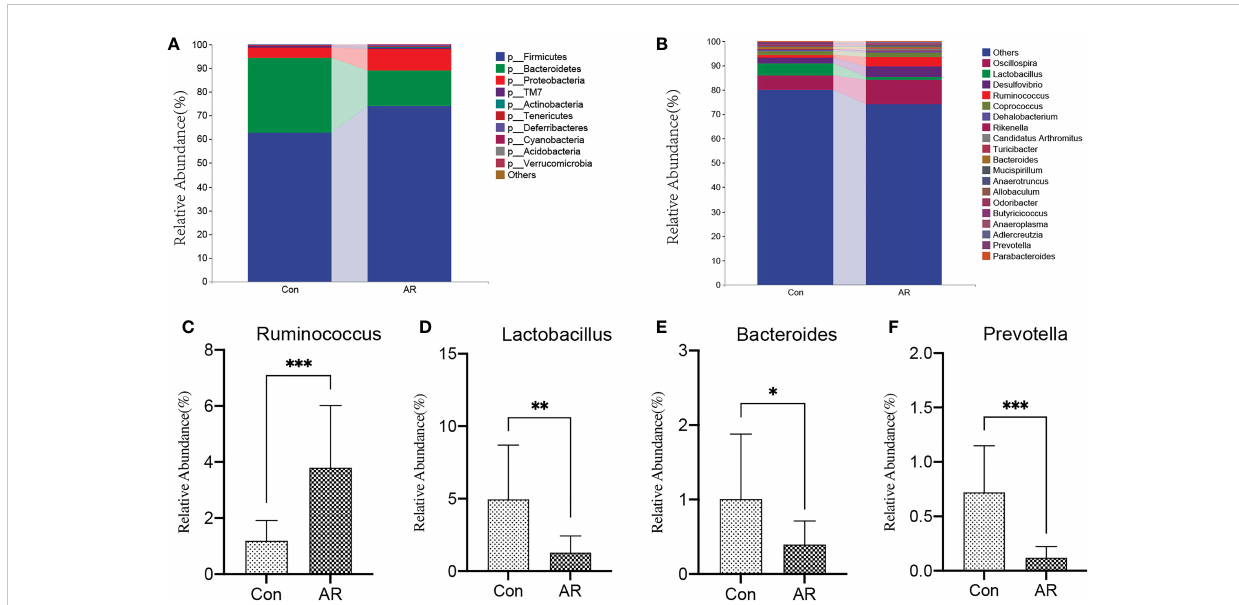
FIGURE 4 AR altered gut microbiota composition at phylum and genus levels. The top 10 phyla (A) and top 20 genera (B) of gut microbiota are colored differently, and the key genera, such as Ruminococcus (C) , Lactobacillus (D) , Bacteroides (E) , and Prevotella (F) are presented. Con group(n=15) vs